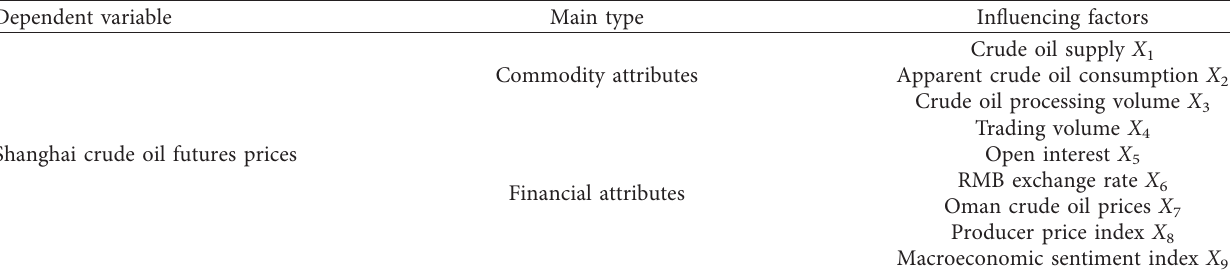
Table 1: Influencing factors of Shanghai crude oil futures price changes.